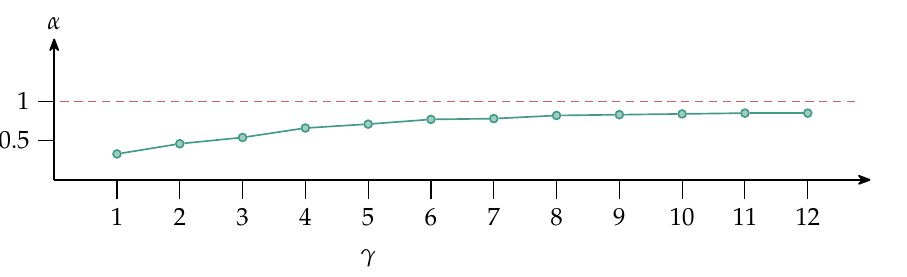
Figure 10. Performance α of a level-2 sieve with γ colorings on instance exact_036 from the PACE 2020 benchmark set [45].